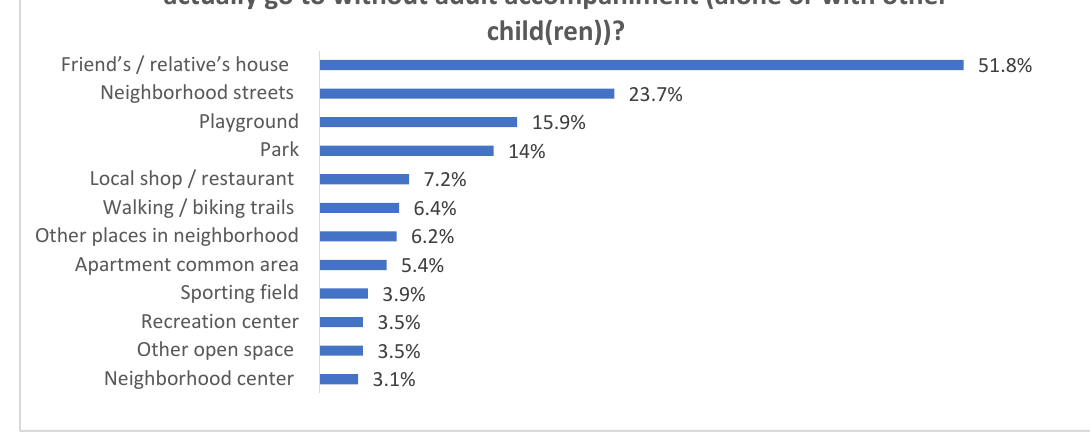
Figure 4. Non-school neighborhood destinations that children actually independently travel to ( n = 515).